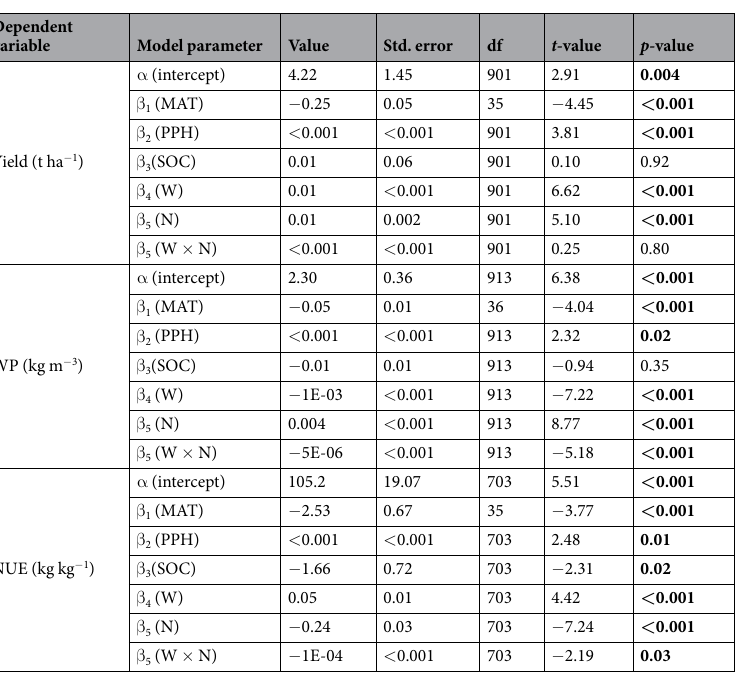
Table 1. Mixed-effects model of the effects of mean annual temperature (MAT), maize planting density (number of plants per hectare, PPH), initial soil organic carbon (SOC), and water (W) and nitrogen (N)